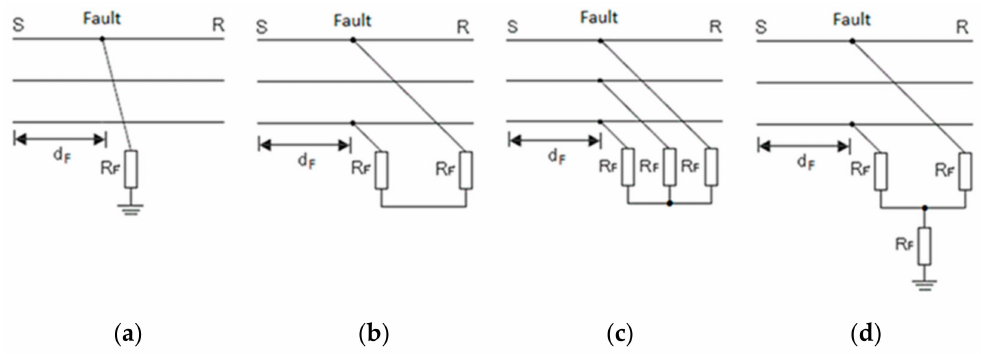
Figure 3. Types of faults: ( a ) SPG (AG, BG, CG); ( b ) DP (AB, AC, BC); ( c ) TP (ABC); ( d ) DPG (ABG, ACG, BCG).